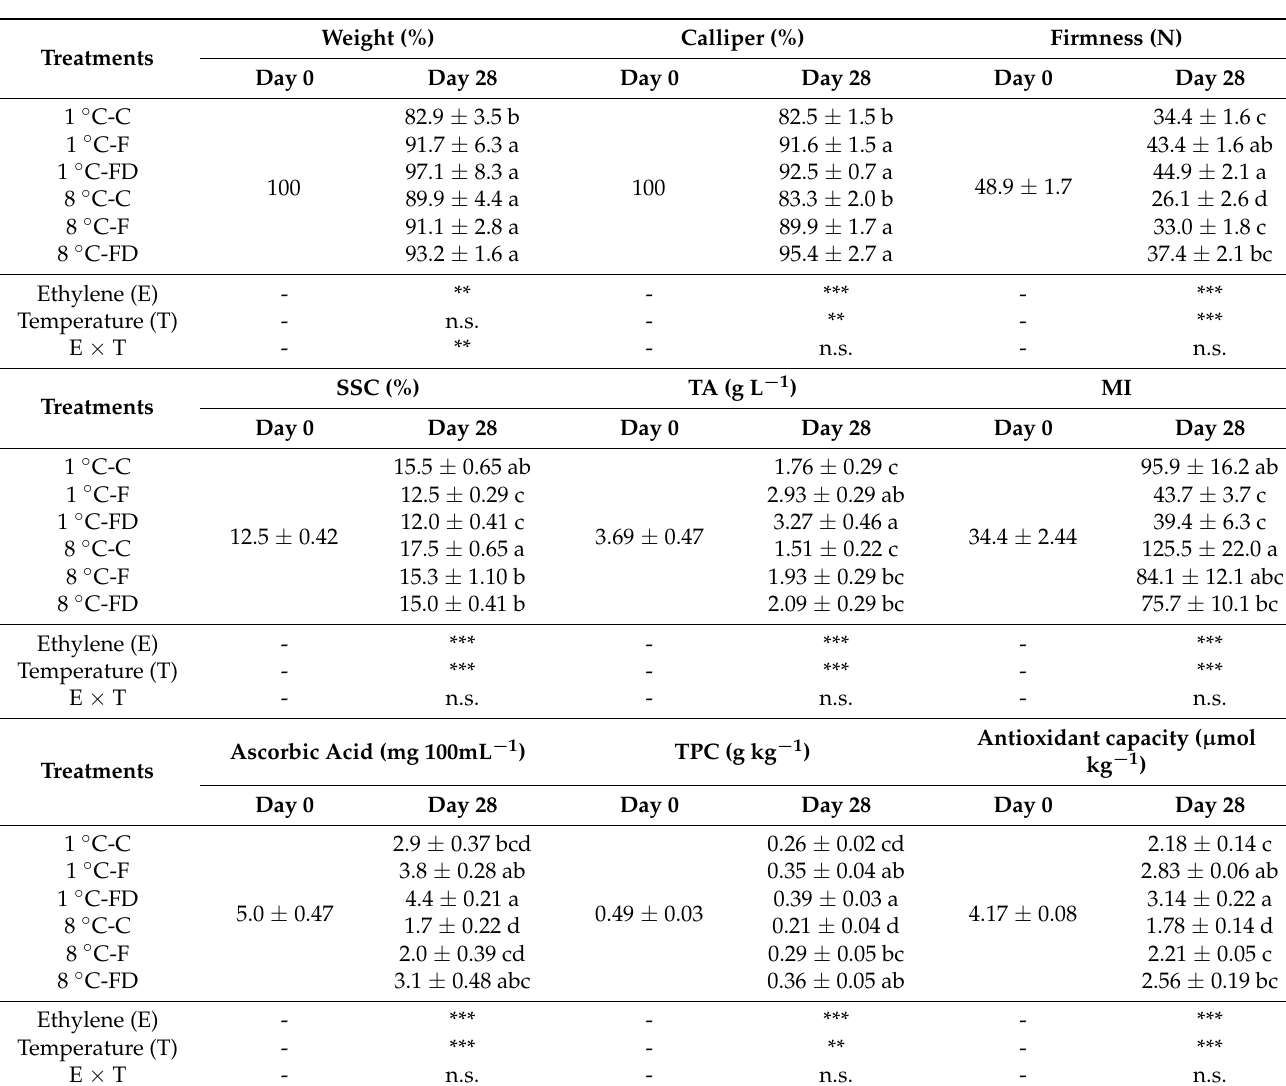
Table 3. Evolution from day 0 to day 28 of the physicochemical variables in pears subjected to the different treatments: 1 ◦ C-C (Control), 1 ◦ C-F (Filter), 1 ◦ C-FD (Filter + Device), 8 ◦ C-C (Control), 8 ◦ C-F (Filter) and 8 ◦ C-FD (Filter + Device). The variables measured were: weight expressed as average percentage compared to day 0 (being day 0 the 100% of average weight value of each treatment individually); calliper expressed as percentage compared to day 0 of each treatment; firmness expressed in Newtons; SSC expressed as percentage; pH; TA expressed as g L − 1 , MI as the SSC (%)/TA (%) ratio; ascorbic acid content expressed as mg 100 mL − 1 ; total phenolic compounds expressed as g galic acid kg − 1 and antioxidant capacity measured with the ORAC method expressed as − 1 . The means ± standard error of the means (SEM) are shown. Different letters µ mol Trollox.Eq. kg for each treatment represent statistically significant differences according to Tukey’s test, n = 5 per treatment and day. The parameters have also been analysed by factors: ethylene (E), temperature (T) and the interaction of both ethylene × temperature (E ×